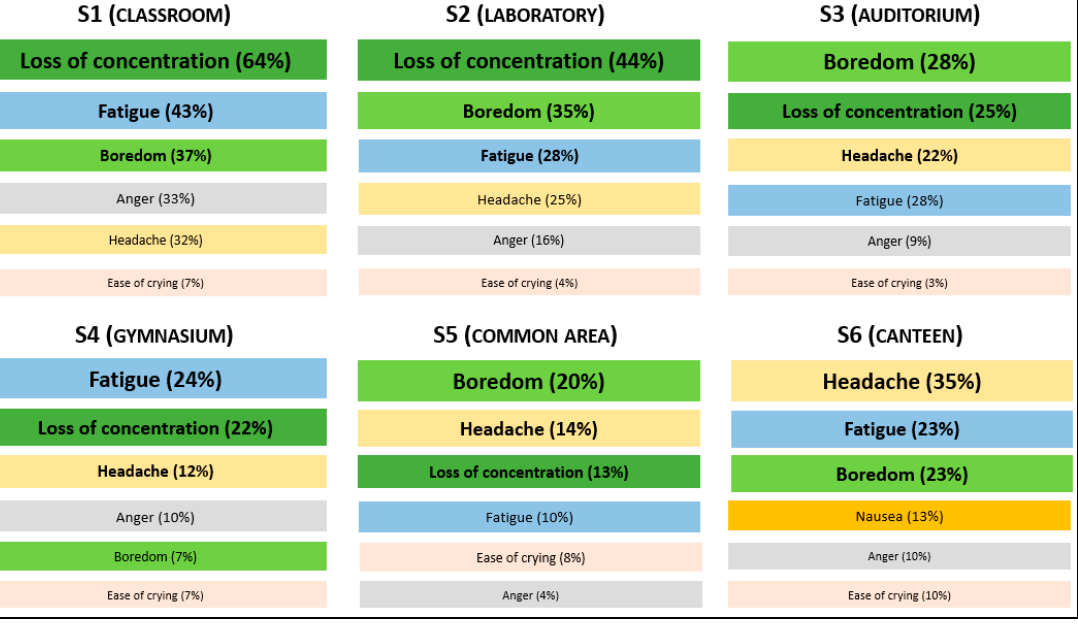
Figure 9. Main extra-auditory effects due to noise exposure in scenarios S1, S2, S3, S4, S5 and S6.